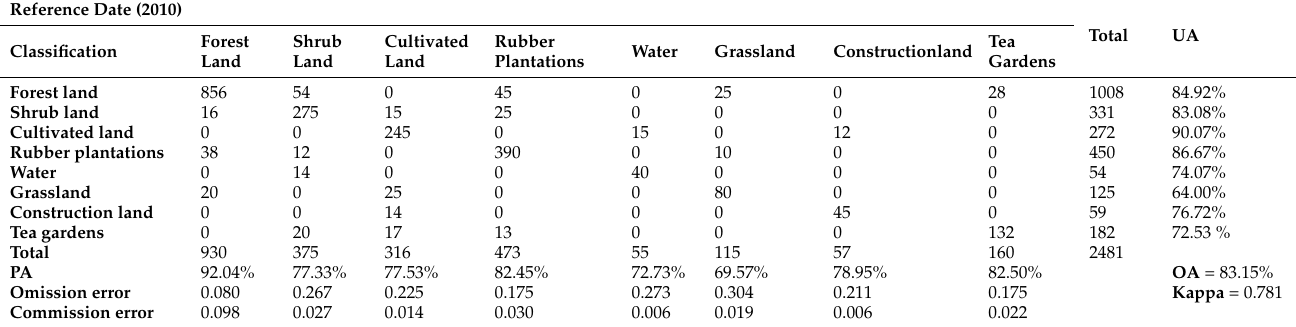
Table A3. The accuracies in